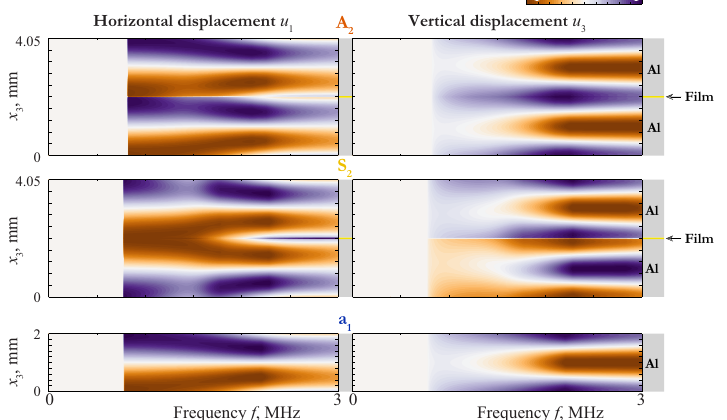
Figure 5. Displacement distribution u k ( x 3 , f ) of LWs A 2 and S 2 propagating in 4.05 mm thickness plate (2 mm aluminium/50 µ m film/2 mm aluminium) and LW a 1 propagating in 2 mm thickness aluminium